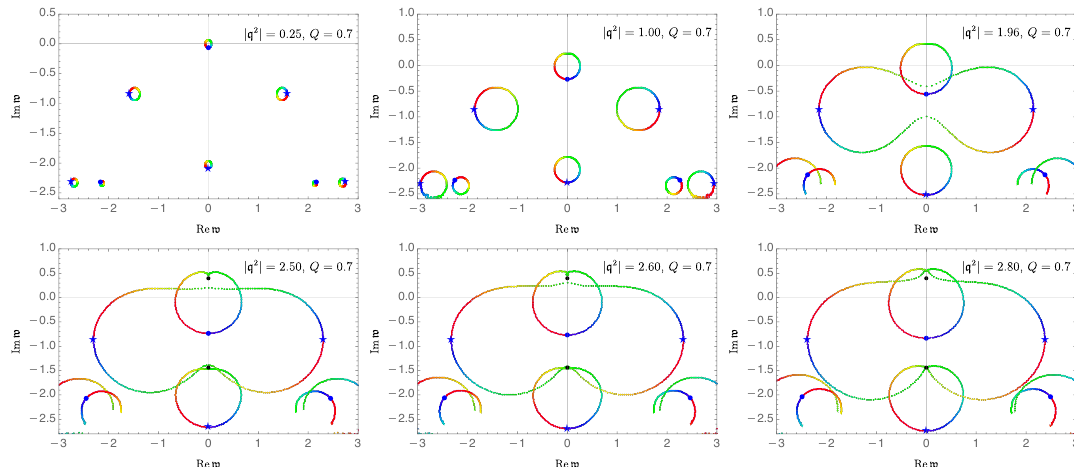
Figure 13. Poles of the retarded two-point function in the spin 1 channel at Q = 0 : 7, in the complex w (cid:0) plane, at various values of the complexi(cid:12)ed momentum q 2 = j q 2 j e i(cid:18) . Large dots and large stars correspond to the poles with purely real momentum (i.e. at (cid:18) = 0). As (cid:18) increases from 0 to 2 (cid:25) , each pole moves counter-clockwise following the trajectory whose color changes continuously from blue to red. At j q 2 j = 0 : 25 (top left panel) all poles follow closed orbits. By increasing j q 2 j , (cid:12)rstly the two lowest star gapped poles collide. After the collision, for instance at j q 2 j = 1 : 96 (top right panel) their orbits are no longer closed; they exchange their positions cyclically as the phase (cid:18) increases from 0 to 2 (cid:25) . At j q 2 j = 2 : 50 (bottom left panel), the orbits of dot poles are still closed. By further increasing j q 2 j , the trajectory of shear pole comes close to those of the nearest dot gapped poles; at j q 2 j = 2 : 60, they nearly collide at the positions marked by black dots (bottom middle panel). Just after the collision, at j q 2 j = 2 : 80 (bottom right panel) the orbits of shear pole and the star pole lying on the imaginary axis are no longer closed; they join to the lowest star poles and form a very complicated orbit. Four of them exchange their positions cyclically as (cid:18) increases from 0 to 2 (cid:25) . However, since the shear mode collides with a gapped pole of (cid:22) J T spectrum, the transition between the last two plots is the manifestation of (cid:22) T (cid:22) J (cid:0)